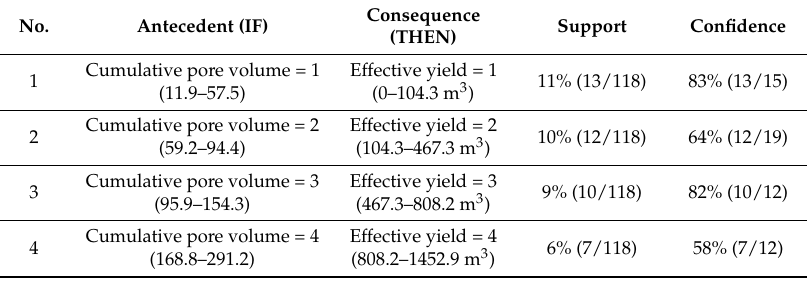
Table 3. Some found rules related to cumulative pore volume and effective